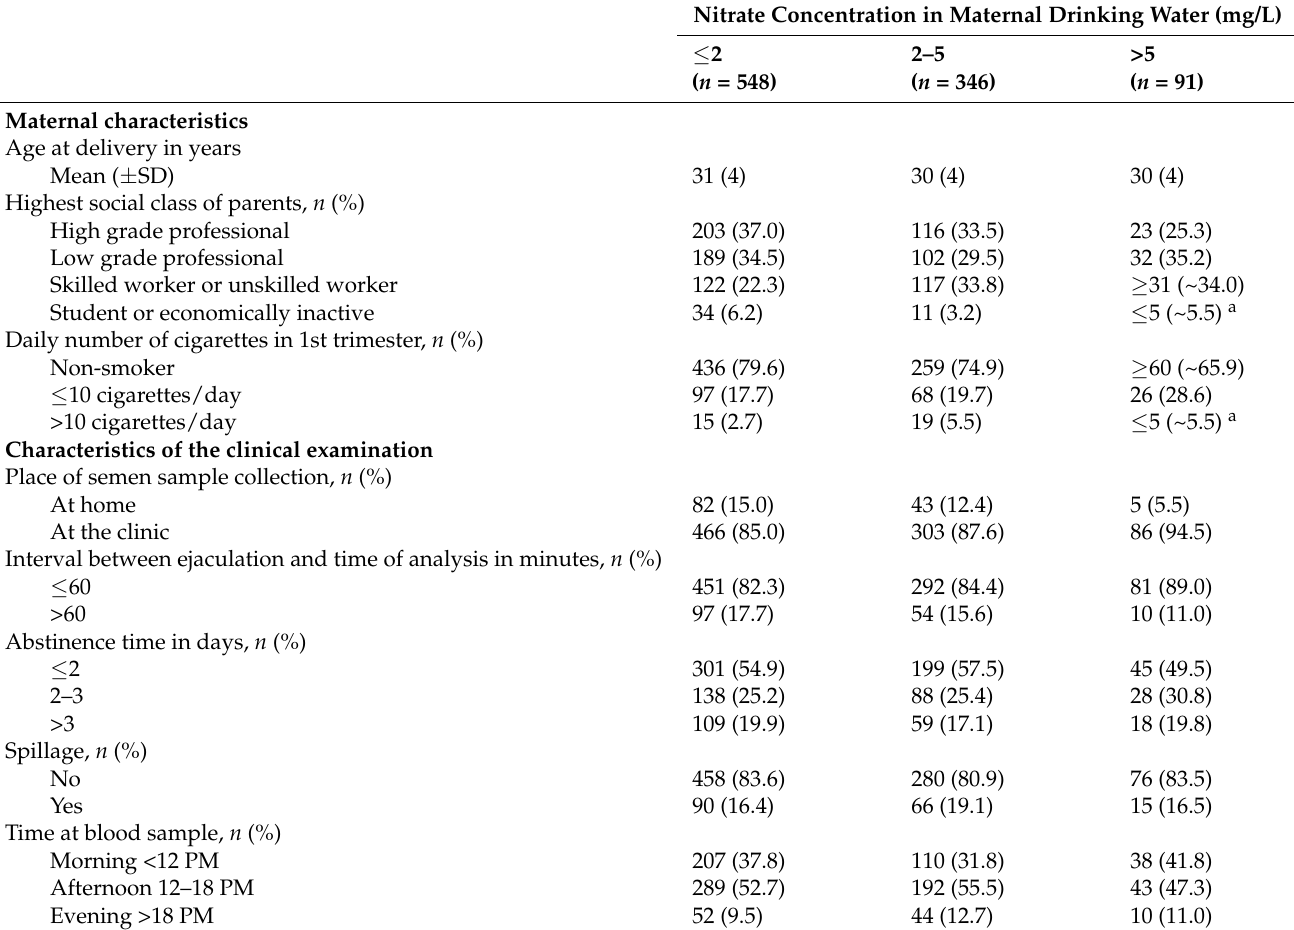
Table 1. Baseline characteristics of the study population in relation to nitrate exposure